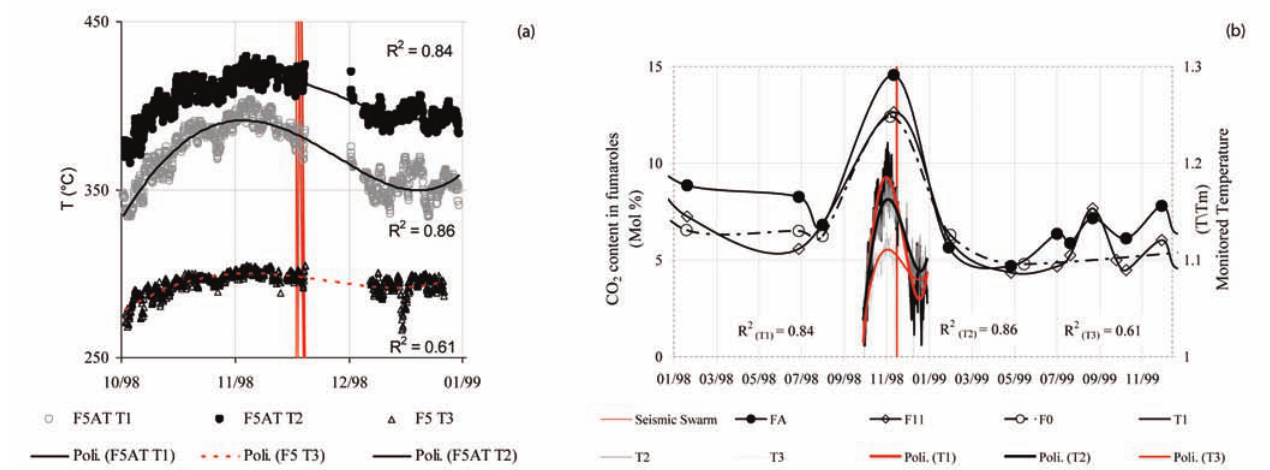
Figure 8. (a) Cyclic variations recorded at the high-temperature fumarole field from October 1998 to December 1998 (1 FT). The 3 data series come from the fumaroles located on the edge of the active cone (T1, T2, from F5AT; T3 from F5). The temperature data were recorded every 2 h, and missing data are due to technical failures caused by the heavy rains that fell after November 20, 1998. The best-fit polynomial curves are shown, with their relative regression coefficients. Red lines, time of the faulting seismic sequence with focal depths ranging from 1 km to 4 km. (see Table 2). (b) CO 2 content and cyclic temperature variations (1 FT) of the fumaroles sampled at the La Fossa cone from January 1998 to November 1999. The 4th order polynomial curves which best fit the recorded data are given, with their relative square regression coefficients (R 2 (T) ). The T values were normalized for easier comparisons according to the equations: and where represents the background reference for each monitored site, here as, respectively: